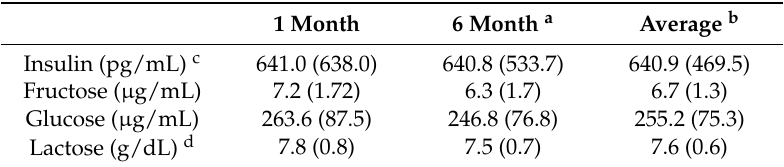
Figure 1. LC-MS/MS (Liquid Chromatography-Mass Spectrometry/Mass Spectrometry) chromatographic traces confirming fructose content in breast milk. ( a ) Natural fructose in breast milk (sample # 108-1); ( b ) Spiked Carbon-13 labeled 13 C 6 -fructose as the internal standard (10 µ g in 50 µ L of breast milk).